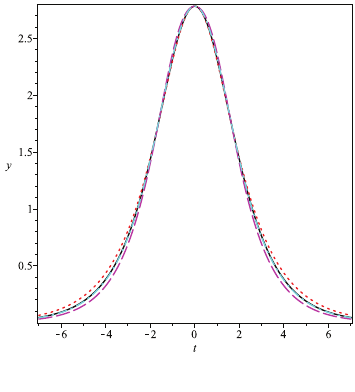
Figure 3. Comparison of various approximations of the homoclinic solution of Eq. (3.3) to the exact solution (solid black line) for ω = σ = 1 . The red dotted, magenta dashed, cyan dash-dotted and blue long-dashed lines correspond to Eq. (3.6), Eqs. (3.8)-(3.9), Eqs. (3.10), and Eqs. (3.11)